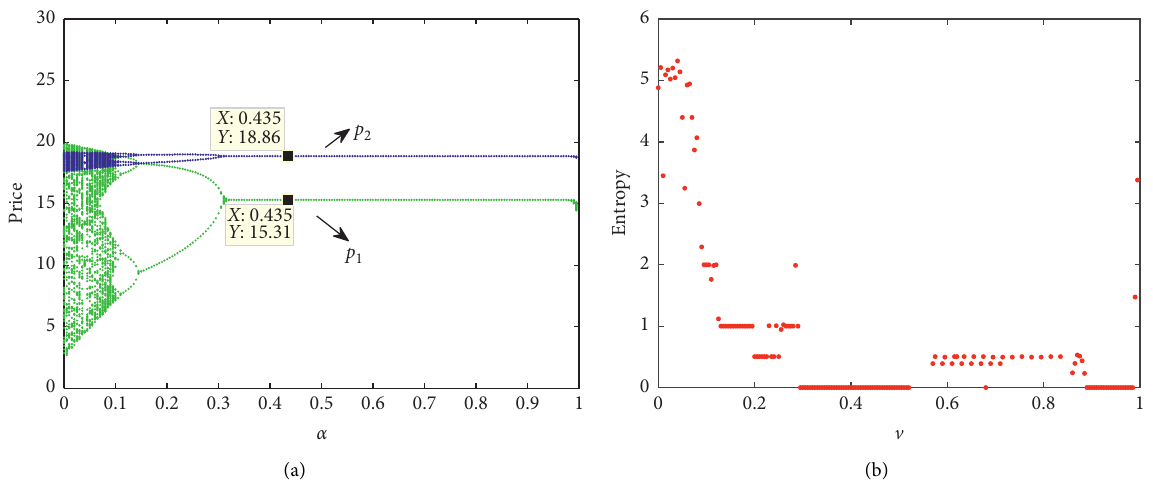
varying. (a) α � 0 . 1. (b) α � 0 . 4. 1